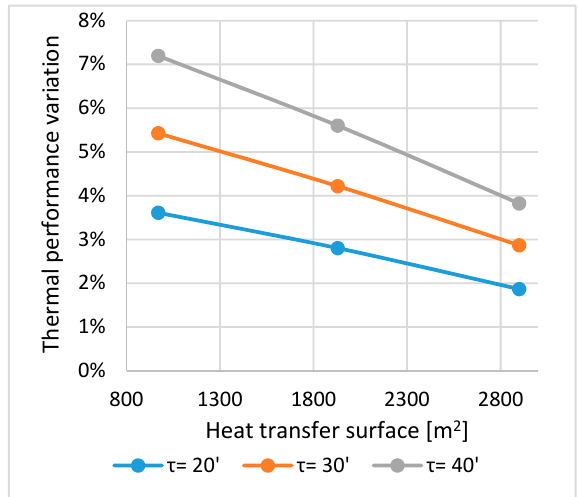
Figure 7. Thermal efficiency variation for different RC sizing and inversion time.